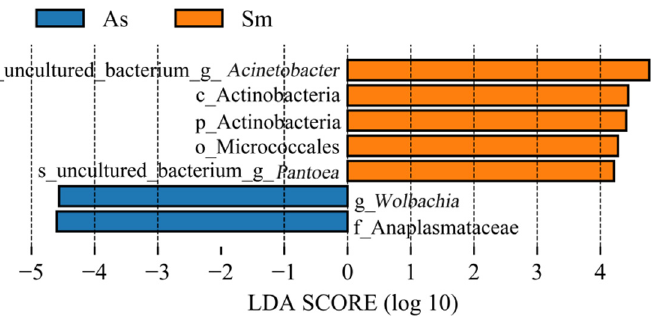
Figure 6. Bacterial taxa with linear discriminant analysis (LDA) score greater than four in the gut microbiota of different grasshopper. As, Atractomorpha sinensis ; Sm, Sphingonotus mongolicus .